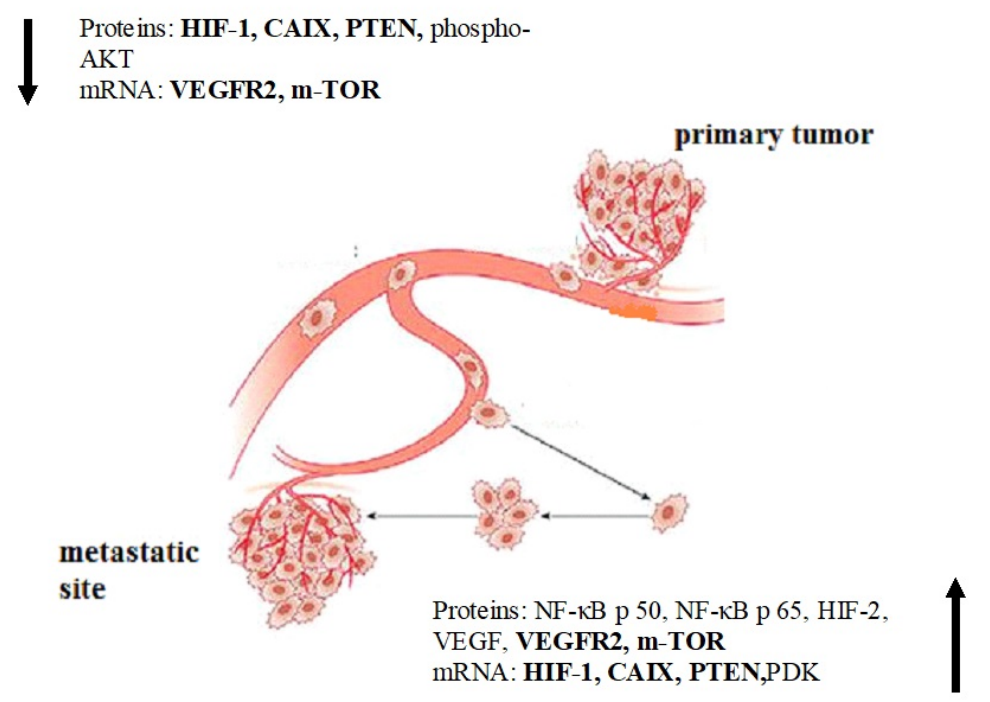
Figure 2. Change in the profile of proteins and mRNAs of molecular factors in the primary tumor of the kidney and its metastatic sites. Note: Arrows indicate changes in the studied factors. We found a decrease in HIF-1, CAIX, PTEN, phospho-AKT content and RNA levels of VEGFR2 and m-TOR in metastases compared to the primary tumors. NF- κ B p50, NF- κ B p65, HIF-2, VEGF VEGFR2 and m-TOR protein contents and HIF-1, CAIX, PTEN and PDK RNA levels were enhanced in secondary cancer lesions. Indicators with change in opposite direction are highlighted in bold. Proteins level and mRNA alterations show the specific trend in biological features of primary tumors and metastases. Despite the reduction in mRNA levels of VEGFR2 and m-TOR, the protein contents of these molecular factors increased. The HIF-1 and PTEN protein levels showed the opposite trend. The kidney cancer aggressiveness is associated with the overactivation of AKT / mTOR signaling pathway and excess of tyrosine kinase receptors.